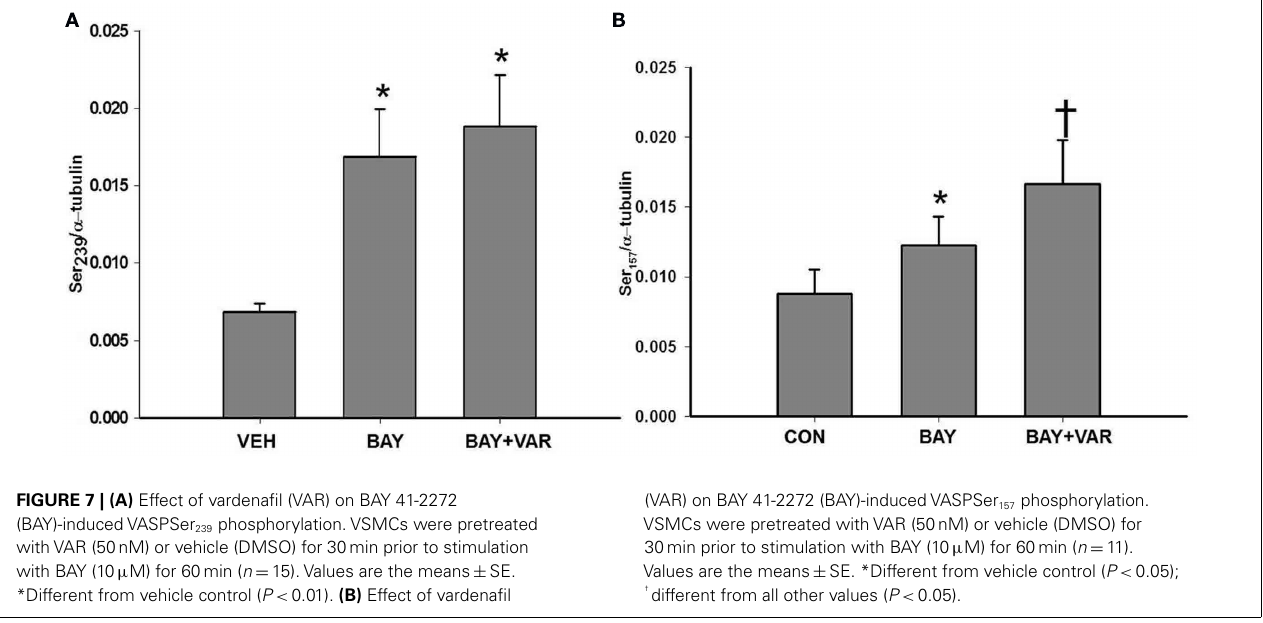
FIGURE 7 | (A) Effect of vardenafil (VAR) on BAY 41-2272 (BAY)-inducedVASPSer 239 phosphorylation.VSMCs were pretreated withVAR (50nM) or vehicle (DMSO) for 30min prior to stimulation with BAY (10 μ M) for 60min ( n = 15).Values are the means ± SE. *Different from vehicle control ( P < 0.01). (B) Effect of vardenafil